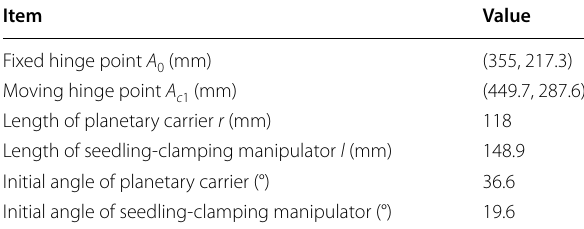
Table 3 Values of each parameter in the optimal